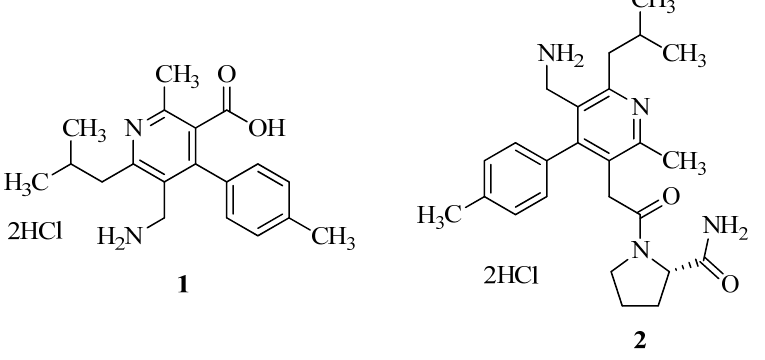
Figure 2. 3-Pyridylacetamide derivatives as DPP-IV inhibitors.